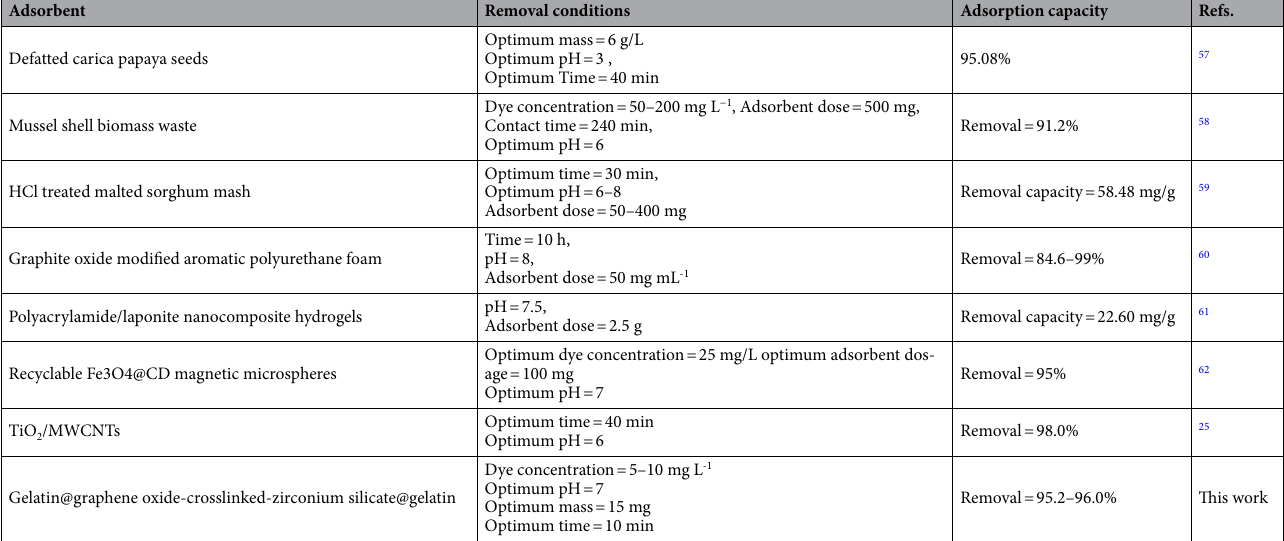
Table 9. Comparison of other adsorbents versus Gel@GO-F-ZrSiO 4 @Gel for removal efficiency of Basic fuchsine